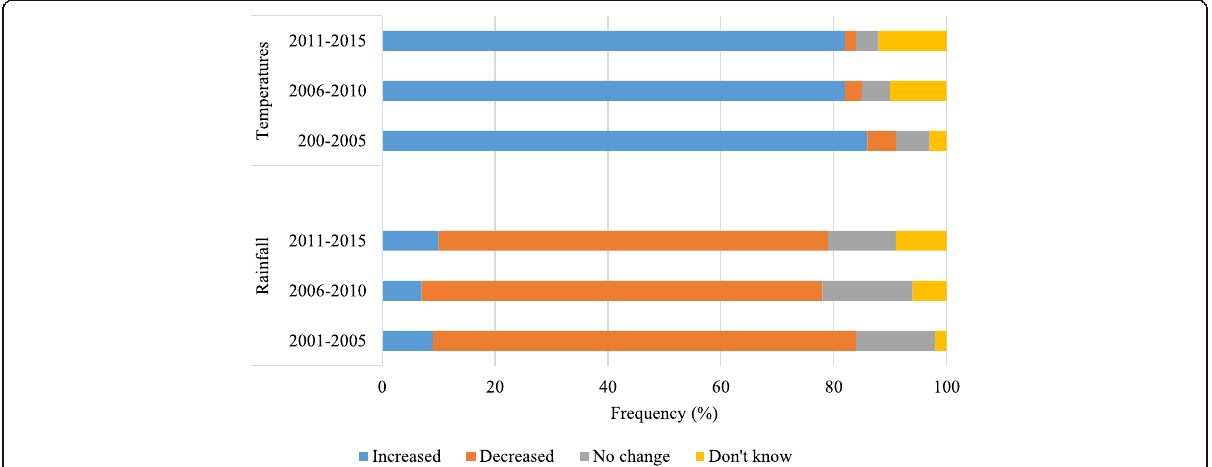
Fig. 5 Smallholders perception about the temperature and rainfall situations in Trans-Mara East between the years 2000 and 2015 (Source: Field Data, 2017)